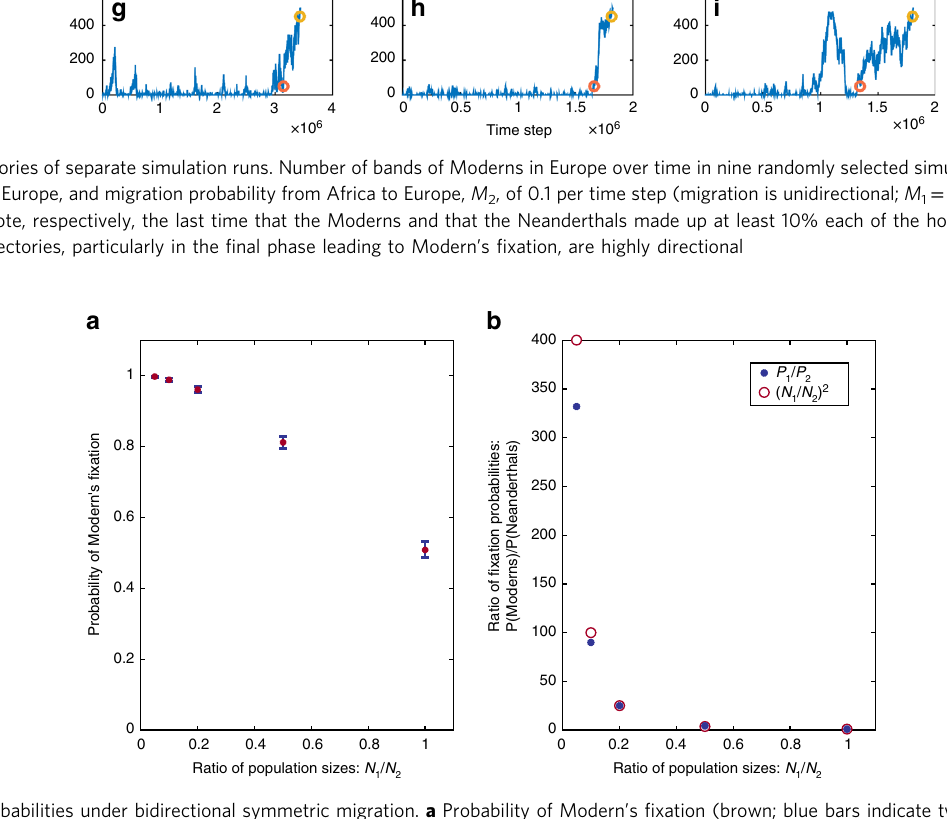
Fig. 4 Fixation probabilities under bidirectional symmetric migration. a Probability of Modern ’ s fi xation (brown; blue bars indicate two standard errors around the observed frequency of fi xation). b Ratio between Moderns ’ and Neanderthals ’ probabilities of fi xation, which is approximated by the square of the inverse of the ratio of population sizes (brown) for much of the range of this ratio. It is slightly lower for scenarios in which the Moderns ’ population is much larger than the Neanderthals ’ . For all runs, m 1 = m 2 = 0.0001, N 2 = 500 (Africa), N 1 refers to Europe. 500 simulation replicates were conducted for each value of N 1 / N